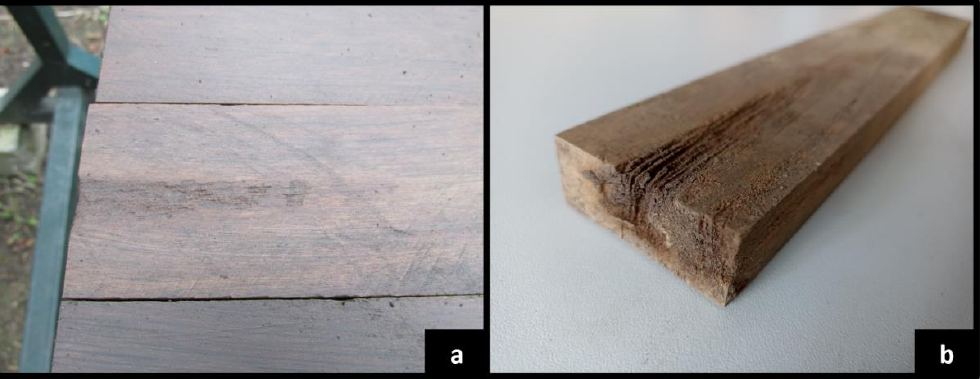
Figure 3. Brown rot in acetylated hornbeam stake Number 7 after 1.5 years ( a ) and 5.5 years ( b ). After 2 years of exposure, three hornbeam and seven beech stakes failed the